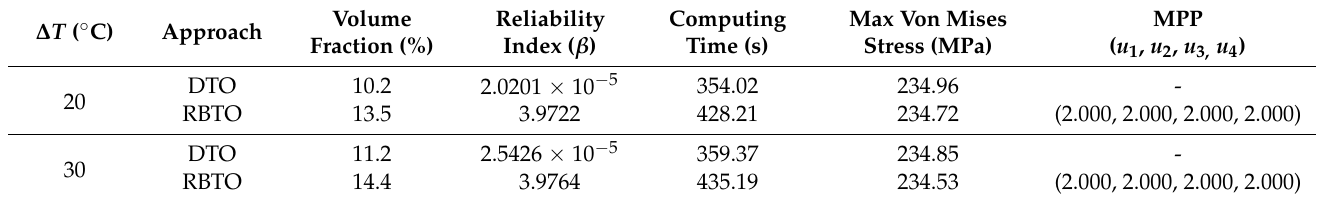
Table 2. Comparison of topology optimization design results.